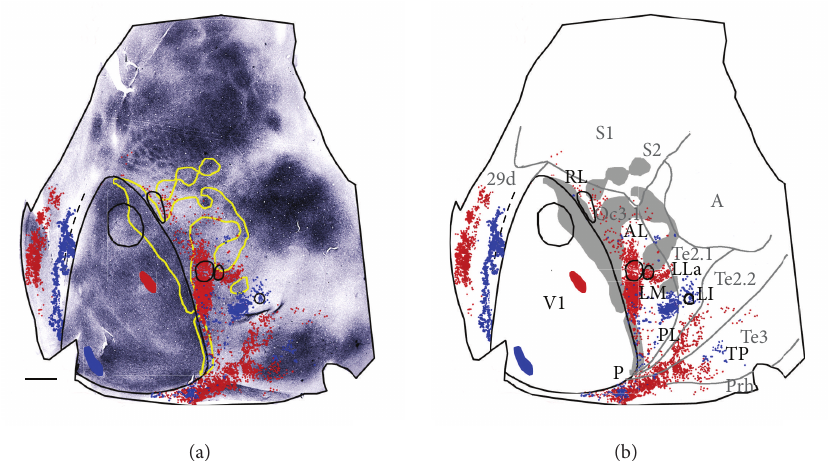
Figure 8: Data from case 86-20. (a) The myelin pattern (also shown in Figure 2(a)) is related to the callosal pattern (yellow contour) and to labeling resulting from injections of tritiated proline, RB, and FB. (b) The location of putative visual areas is indicated. Callosal pattern is represented in grey. Medial is to the left and posterior is down. Scale bar = 2